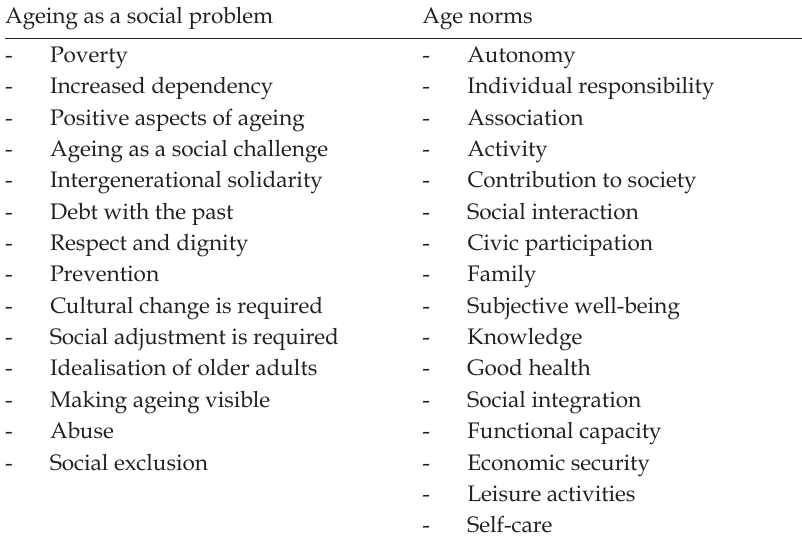
Table 1. List of